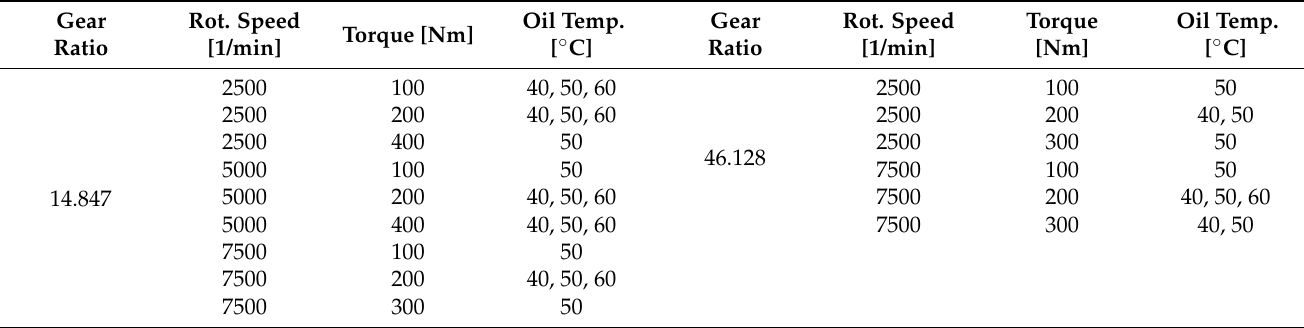
Table 1. Overview of load cases that were carried out on the test